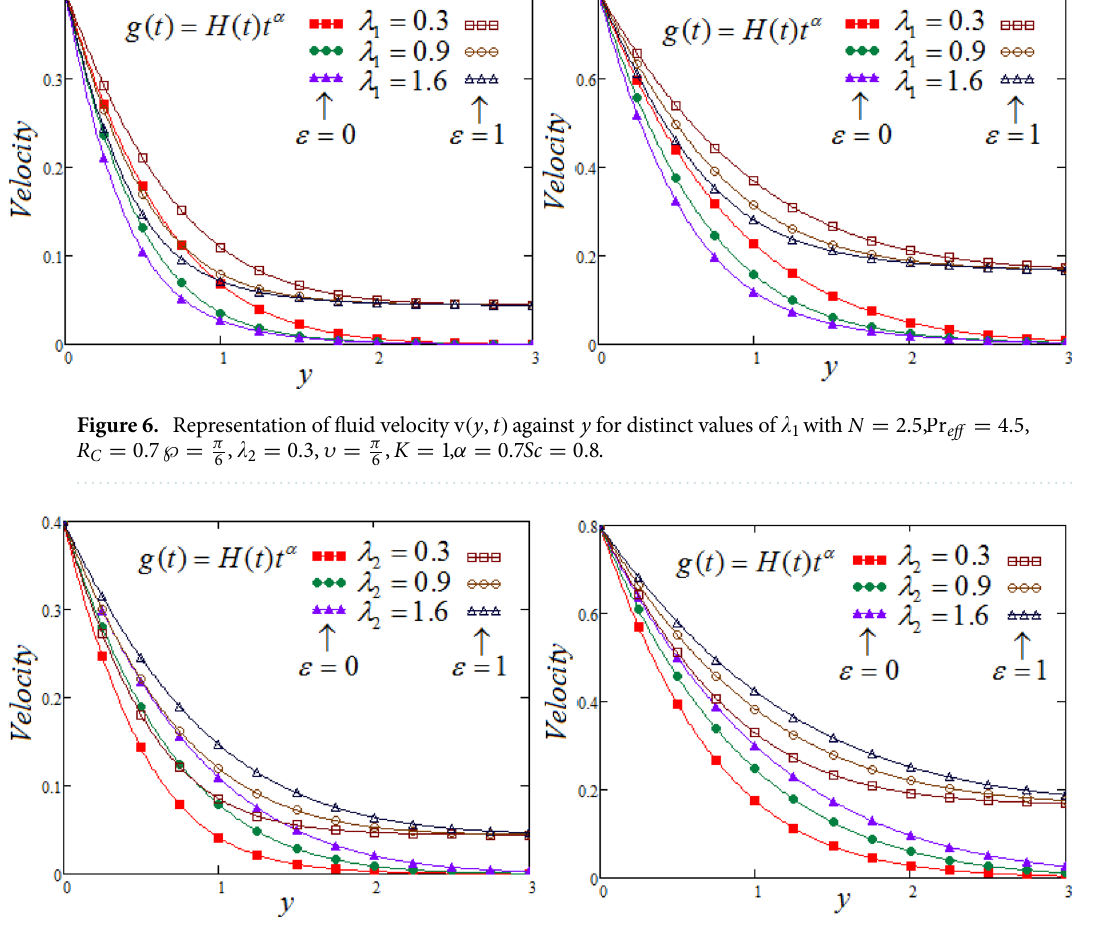
Figure 7. Representation of fluid velocity v ( y , t ) against y for distinct values of (cid:31) 2 with R C = 0.7, N = 2.5, = 4.5, ℘ = π , (cid:31) 1 = 0.7, υ = π , K = 1 , α = 0.7 Sc = 0.8 Pr eff 6 6